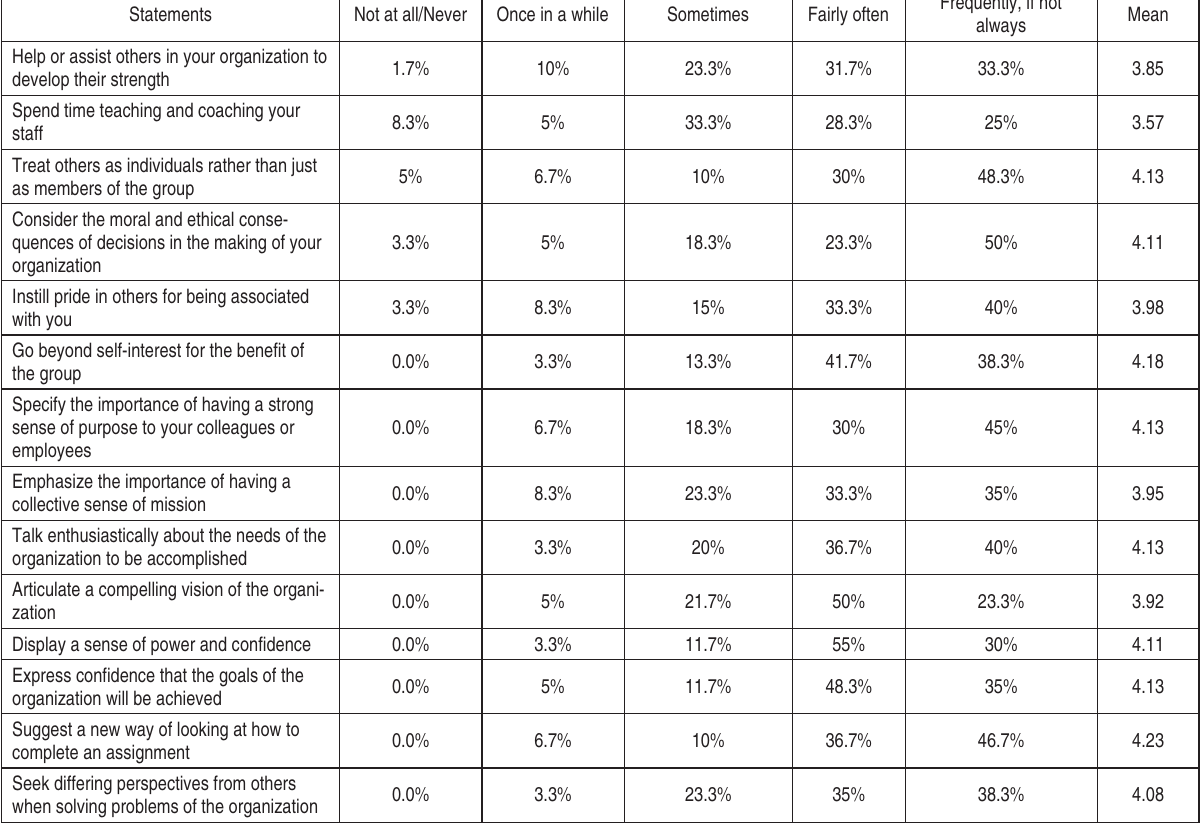
Table 2. Transformational leadership styles of the manager/supervisor